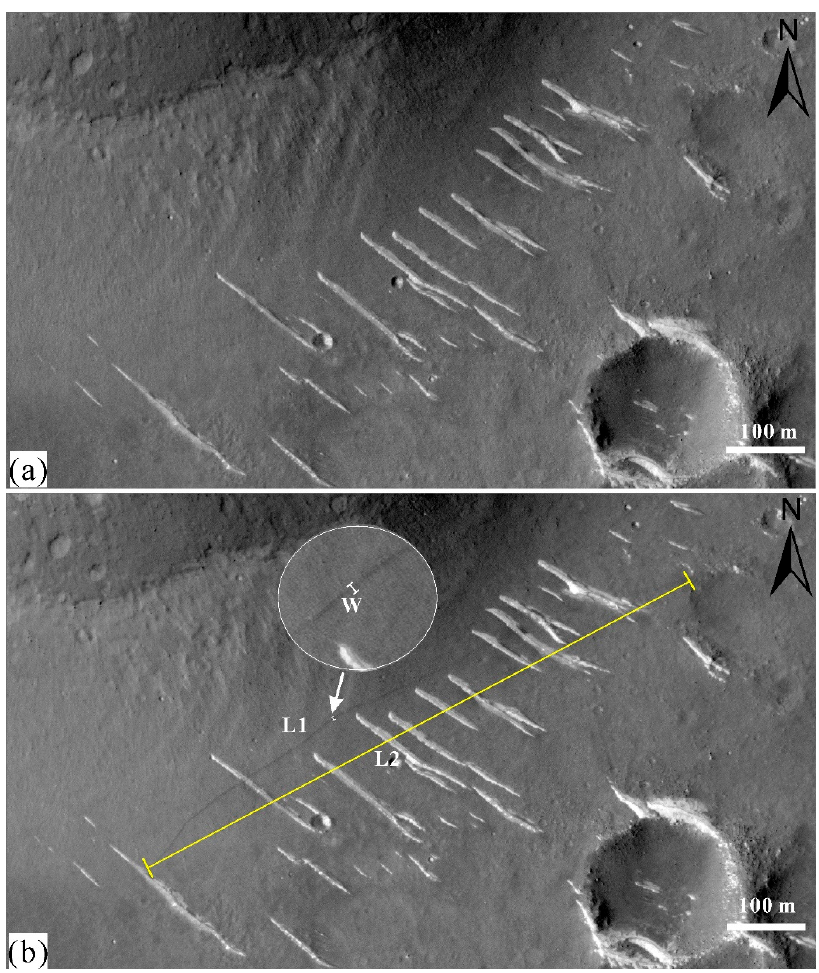
Figure 3. An example of newly formed dust devil tracks in image pair 5. ( a ) Part of HiRISE image ESP_043896_2055 at Ls = 78° in MY 33. ( b ) Part of CTX image ESP_044885_2055 at Ls = 112.3° in MY 33. The central point coordinates of ( a ) and ( b ) are 110.445°E, 25.076°N. L 1 is the length along the total path, L 2 is the distance between the start and end point of DDTs (the yellow line), and W is the width.